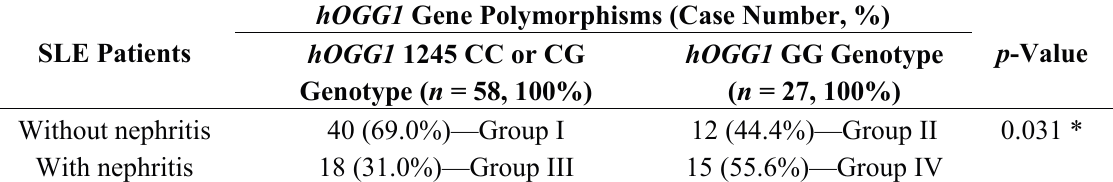
Table 3. Distribution of hOGG1 gene polymorphisms in SLE patients with or without lupus